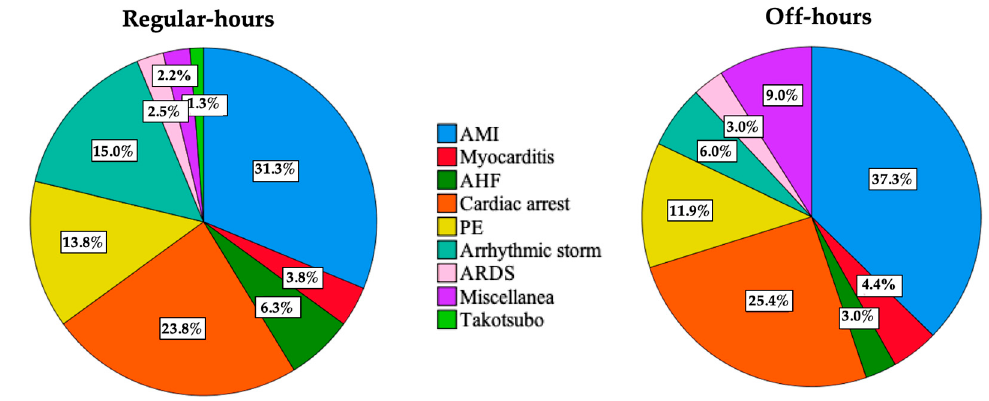
Figure 2. Reasons for venoarterial extracorporeal membrane oxygenation indication. No significant differences were found between regular-hours and off-hours groups ( p = 0.467). AMI: acute myocardial infarction. AHF: acute heart failure. PE: pulmonary embolism. ARDS: acute respiratory distress syndrome.